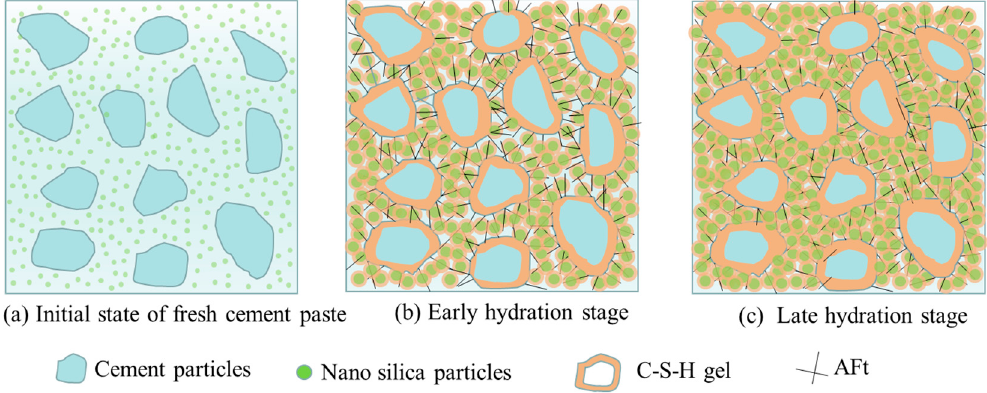
Figure 11. The hydration process of NS ‐ precipitated cementitious materials.